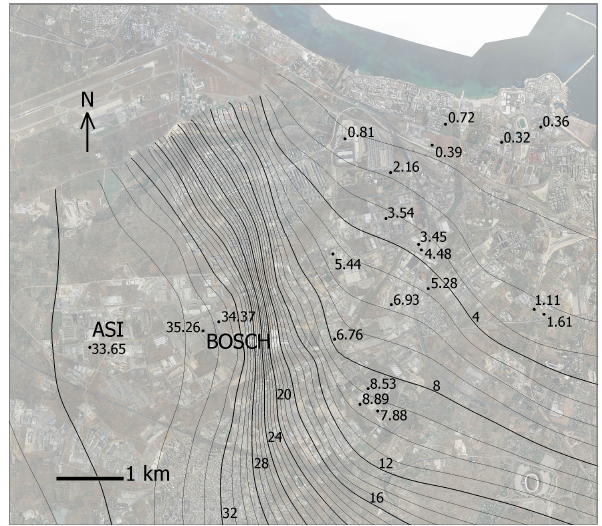
Figure 9. Map of simulated hydraulic